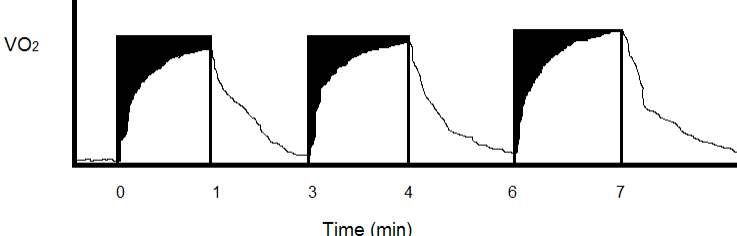
Figure 3. Divide continuous steady state aerobic exercise (Figure 2) into work equivalent or paired higher intensity intermittent periods and the total energy costs tend to increase. aerobic (white) in-series metabolic inefficiency at the onset of each exercise bout and the increased O uptake of multiple recovery periods when lactate and fat (at 1 L O = 19.6 kJ) 2 2 as opposed to glucose (at 1 L O = 21.1 kJ) are oxidized to meet energy demands. With 2 intermittent resistance exercise, the summed recovery O uptake after each lifting period 2 can greatly exceed the oxygen consumed during the actual weight lifting periods